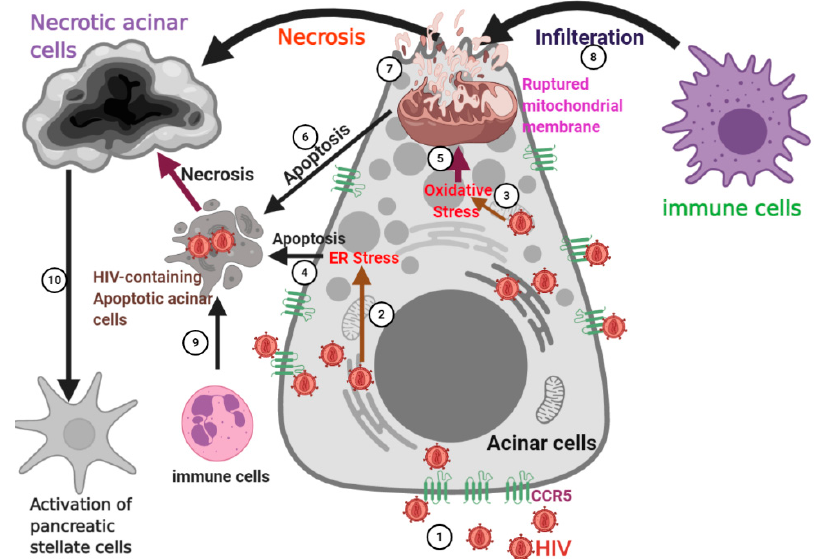
Figure 1. An HIV-exposed pancreas. Visual depiction of the pathogenesis of HIV-induced pancreatitis. We hypothesize that HIV undergoes some events to mediate its toxicity on pancreatic acinar cells and these include: (1) HIV entry via C-C chemokine receptor type 5 (CCR5) receptors which are adequately expressed on acinar cells; (2) HIV proteins triggering ER stress in the ER; (3) HIV proteins triggering oxidative stress in mitochondria; (4) ER stress triggering apoptosis; (5) oxidative stress triggering mitochondrial membrane rupture; (6) Ruptured mitochondrial membrane triggered apoptosis or (7) necrosis; (8) infiltrating immune cells necrotizing HIV-containing acinar cells; (9) infiltrating immune cells necrotizing HIV-containing apoptotic acinar cells; (10) necrotic acinar cells activating the pancreatic stellate cells, leading to pancreatic inflammation and